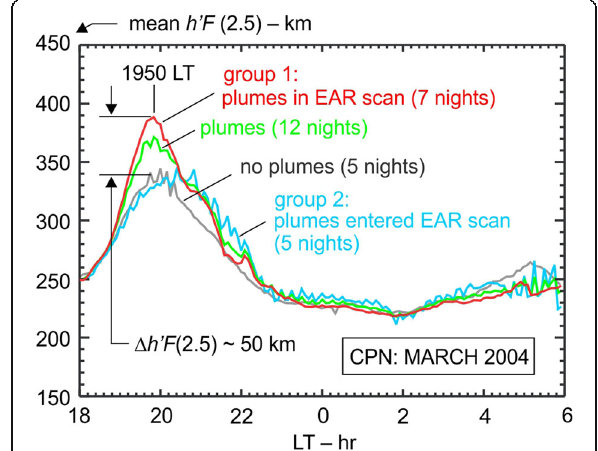
Fig. 5 Composite plots of mean h ’ F (2.5) vs LT, constructed by averaging curves taken at CPN, from 17 nights in March 2004. The gray curve is the mean of five nights of no plumes; green curve is the mean of 12 nights containing plume activity. The red curve (labeled group 1) is the mean of seven nights, when plumes appeared in the EAR scanned sector; blue curve (labeled group 2) is the mean of five nights, when plumes entered the EAR scanned sector. These curves were extracted from Figs. 7 and 8 in Fukao et al. (2006). Mean SSN for 2004 was